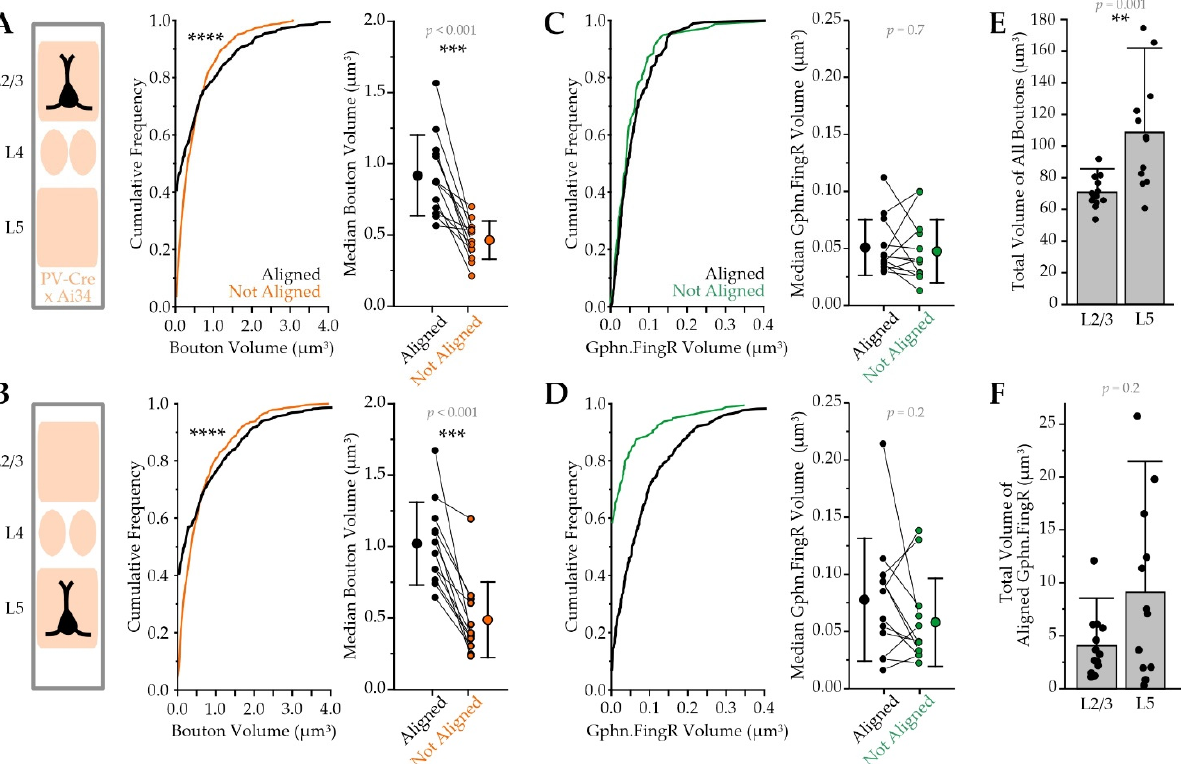
Figure 8. Gephyrin-lacking PV synapses have smaller boutons. ( A ) left: cortical column schematic; middle: cumulative frequency plot comparing L2/3 Pyr neuron somatic PV-Syn bouton volume for boutons that were either aligned with postsynaptic Gephyrin.FingR (black line) or not aligned (orange line; Kolmogorov-Smirnov Test, p < 0.0001); right: L2/3 Pyr cells’ median PV bouton volume for Gephyrin.FingR aligned and not aligned boutons with values from the same cell connected by lines and group averages (mean ± SD) to the left and right of individual cell values, paired comparison performed using Wilcoxon Signed Ranks Test; ( B ) as in A, but for L5 Pyr neurons; ( C ) left: cumulative frequency plot of L2/3 Pyr neuron somatic Gephyrin.FingR volumes for puncta that were aligned with PV boutons (green line) or not aligned (black line; Kolmogorov-Smirnov Test, p = 0.4), right: L2/3 Pyr cells’ median Gephyrin.FingR puncta volume for aligned and not aligned puncta with values from the same cell connected by lines and group averages (mean ± SD) to the left and right of individual cell values, paired comparison performed using Wilcoxon Signed Ranks Test; ( D ) as in ( C ), but for L5 Pyr neurons (Kolmogorov-Smirnov Test, p = 0.2); ( E ) total volume of all PV boutons associated with individual L2/3 and L5 Pyr neuron somas; ( F ) total volume of all Gephyrin.FingR puncta that could be aligned with PV boutons for individual L2/3 and L5 Pyr neuron somas; ** p ≤ 0.01, *** p ≤ 0.001, **** p ≤ 0.0001; L2/3, n = 13 cells; L5, n = 12 cells; N = 2